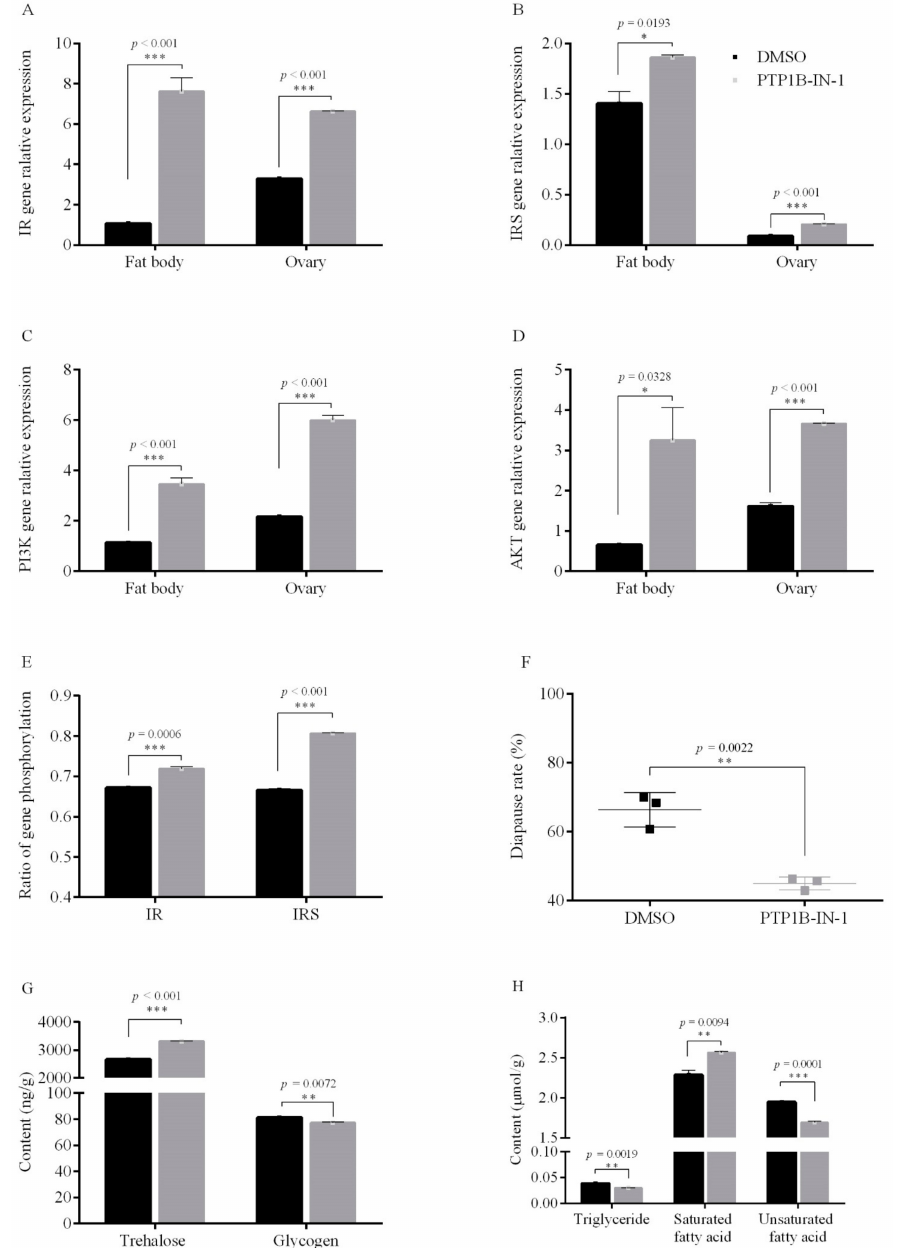
Figure 2. Gene relative expression, phosphorylation level, energy metabolism and egg diapause incidence after injection of adults with PTP1B inhibitor PTP1B-IN-1 compared to DMSO (control) under short photoperiod conditions (L10:D14). ( A ) IR gene, ( B ) IRS gene, ( C ) PI3K gene, ( D ) AKT gene, in the fat bodies and ovaries, ( E ) phosphorylation levels of IR and IRS in the 10-days-old eggs, ( F ) egg diapause incidence, ( G , H ) energy metabolism in the 10-days-old eggs. Data are the mean ± SEM from three independent replicates, the gray bar indicates PTP1B inhibitor treatments, while the black bar indicates DMSO controls (* p < 0.05, ** p < 0.01, and *** p < 0.001 vs. DMSO controls, Student’s t